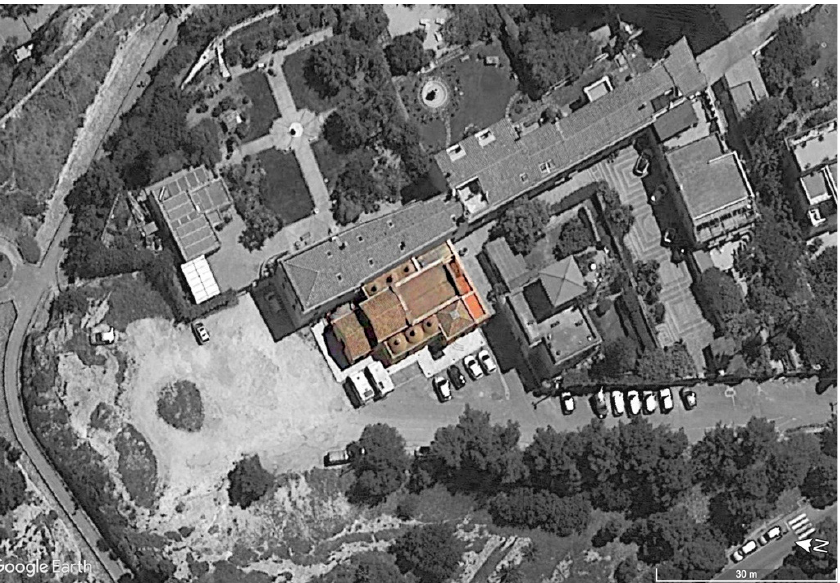
Figure 1. Aerial view of the ancient Romanesque church of Saints Lorenzo and Pancrazio, which dates from the second half of the 13th century and is located in the historical town of Cagliari (Italy) (elaborated from Google Earth).